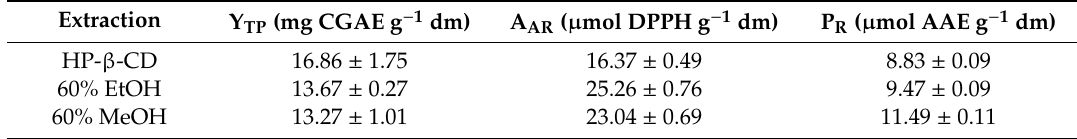
Table 3. Comparison of the characteristics of the extract obtained with HP- β -CD with those of common conventional solvents. Values reported are means ± standard deviation.